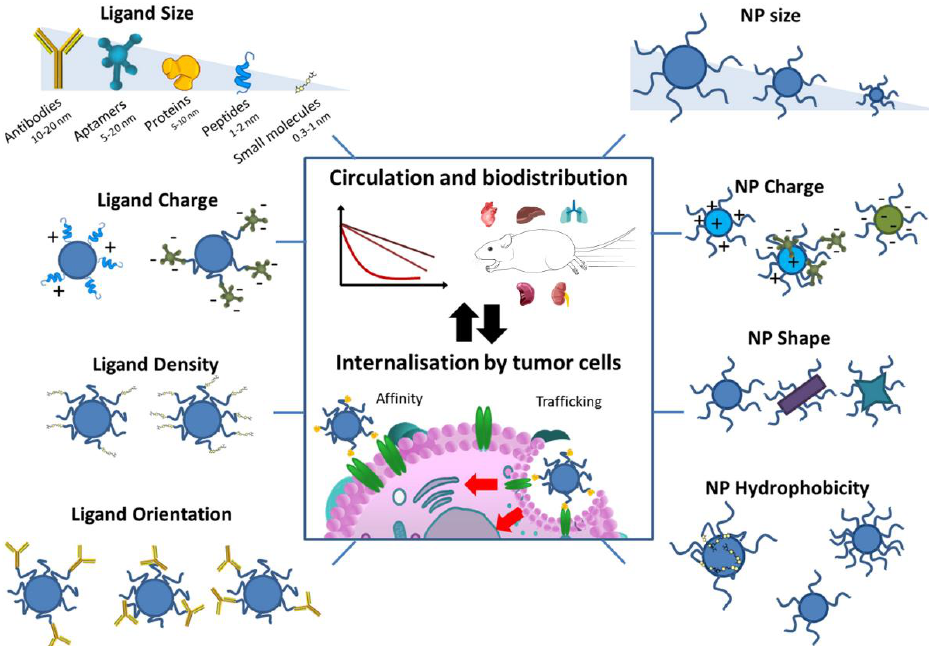
Figure 5. Physicochemical properties of ligands and NPs affecting blood circulation profiles, bio- distribution, and the internalization of ligand-functionalized nanocarriers [42]. Reprinted with per- mission from ref. [42]. Copyright 2014 Elsevier.